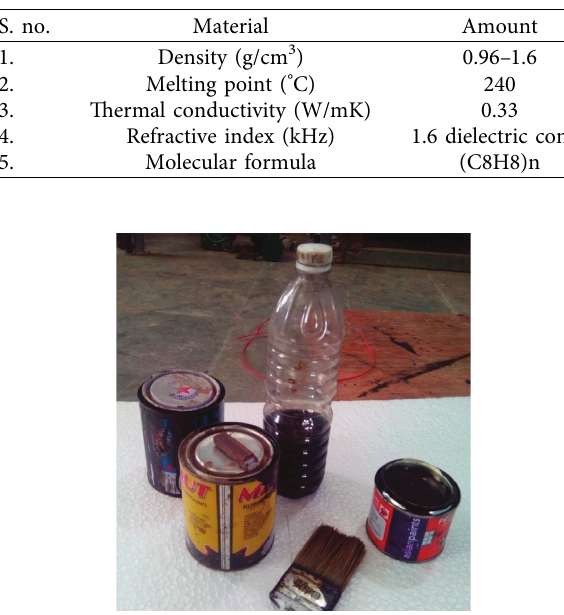
Figure 7: Solar dryer with thermocol insulation. Table 4: Aluminium tray size and material.